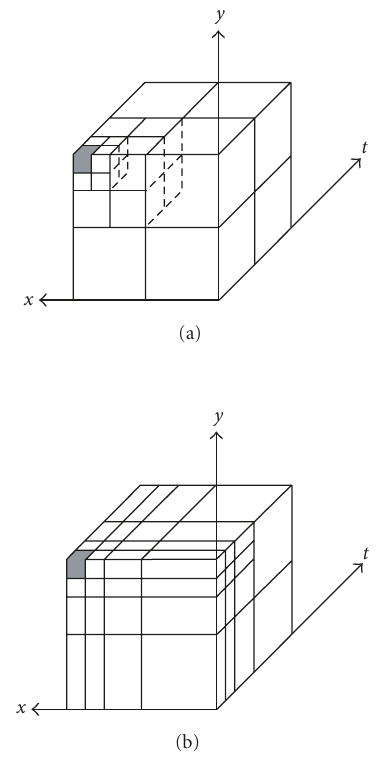
Figure 1: (a) Classic and (b) nonalternating classic 3D wavelet de- composition